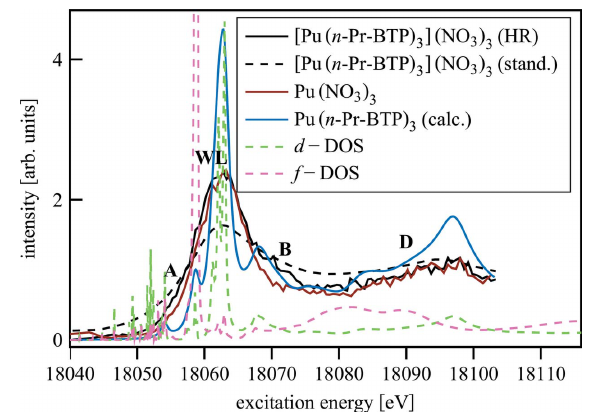
Figure 12 Pu L 3 -edge HR-XANES of [Pu( n -Pr-BTP) 3 ](NO 3 ) 3 and Pu(NO 3 ) 3 ; Pu L 3 -edge XANES of [Pu( n -Pr-BTP) 3 ](NO 3 ) 3 ; FDMNES calculations of Pu(H-BTP) 3 XANES and